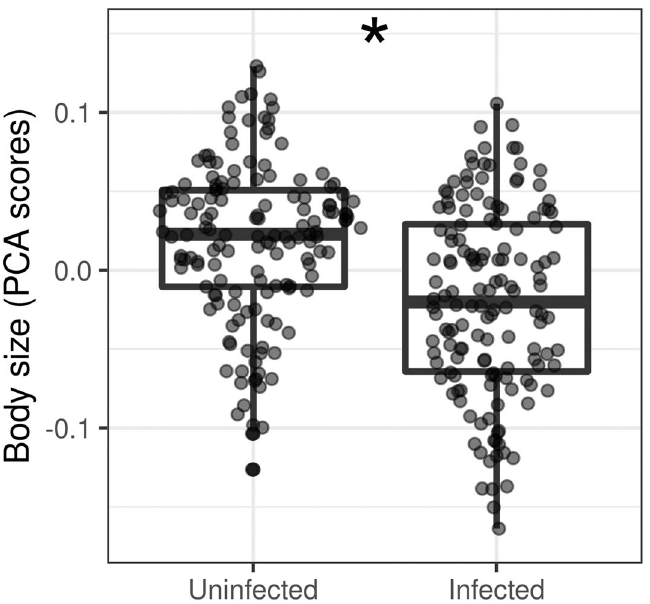
Figure 1. Distribution of PCA axis values representing body size in uninfected and infected colonies. Asterisk marks statistically significant